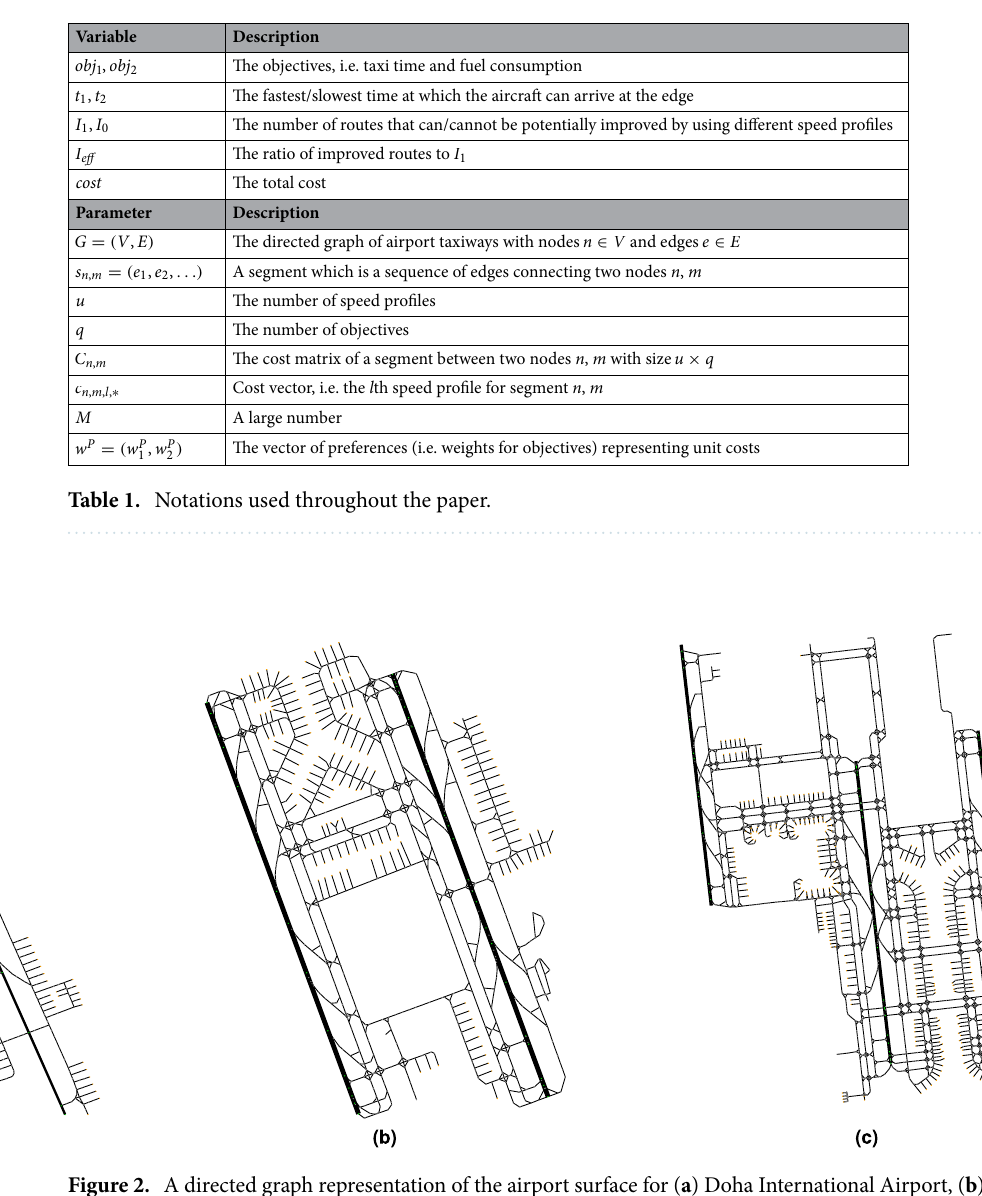
Figure 2. A directed graph representation of the airport surface for ( a ) Doha International Airport, ( b ) Hong Kong International Airport, ( c ) Beijing Capital International Airport.